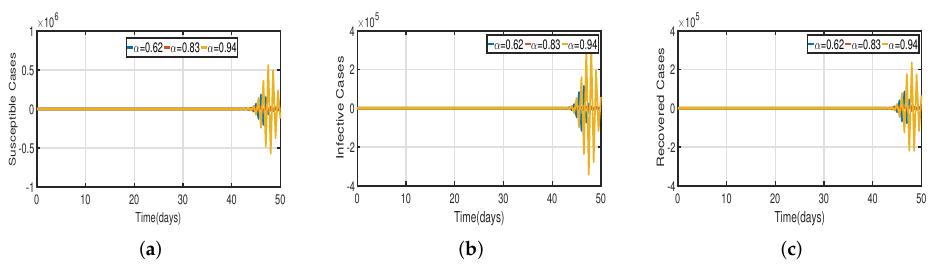
Figure 9. Vaccination model (2) with time delay τ > τ 0 . ( a ) Susceptible S ( t ) . ( b ) Infected I ( t ) . ( c ) Recovered R ( t ) .